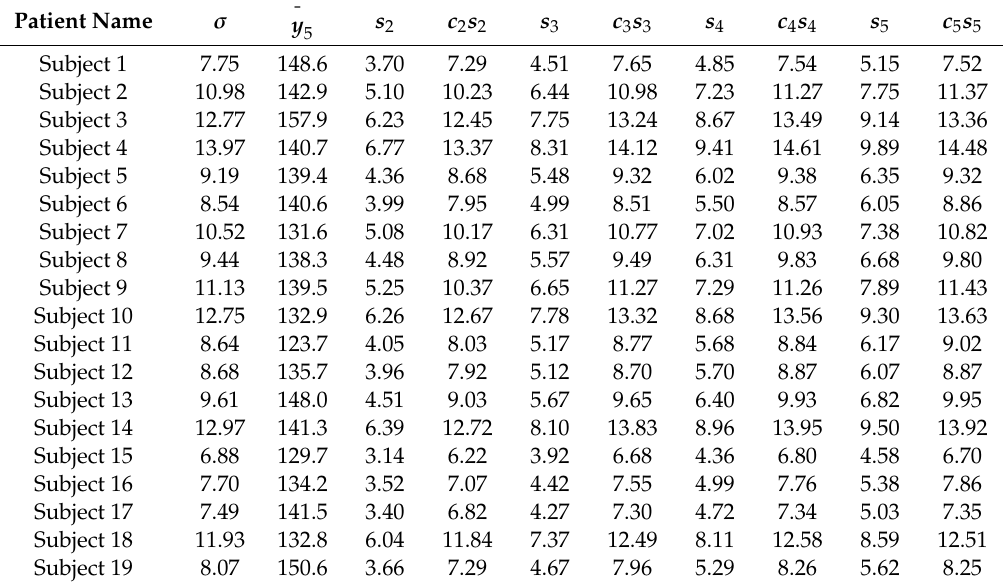
Table 3. Expected Value and Standard Deviation Estimation of Fetal Heart